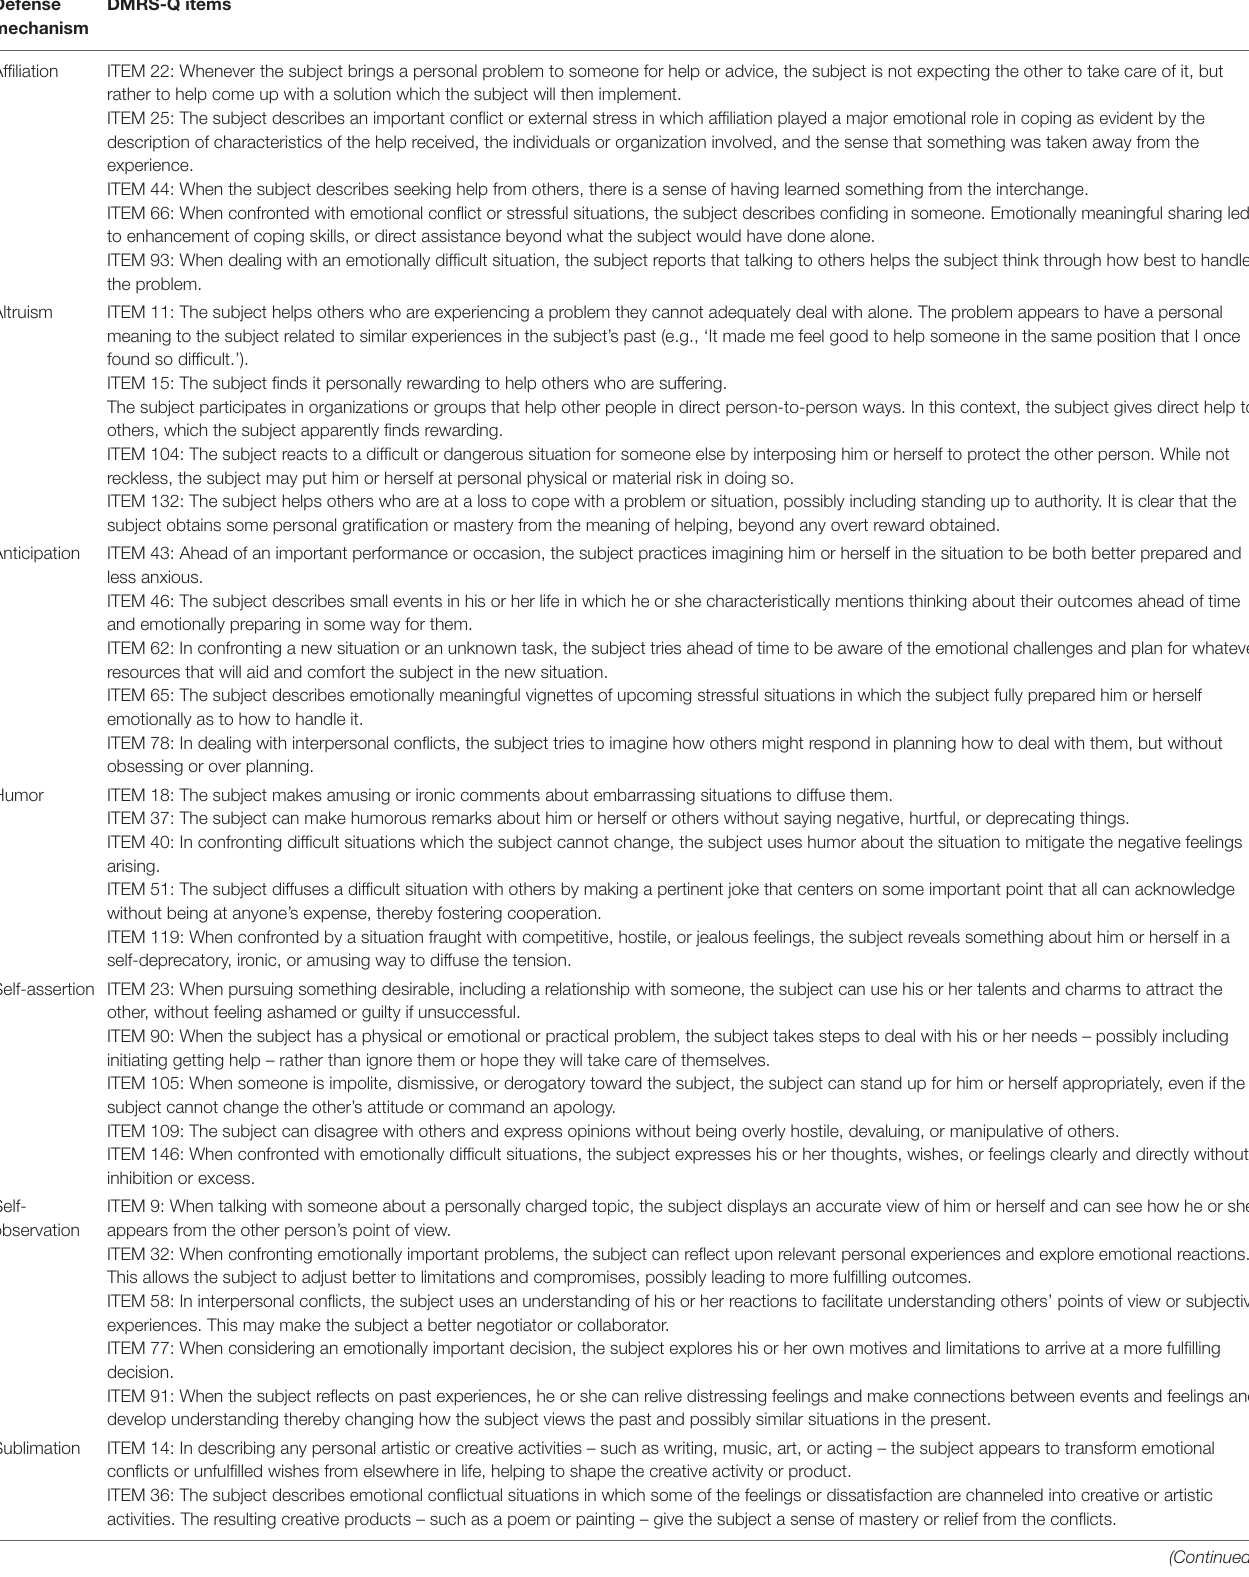
TABLE 2 | High-adaptive defense level: Definition, function and DMRS-Q items of defenses affiliation, altruism, anticipation, humor, self-assertion, self-observation, sublimation, and suppression. Defense DMRS-Q mechanism